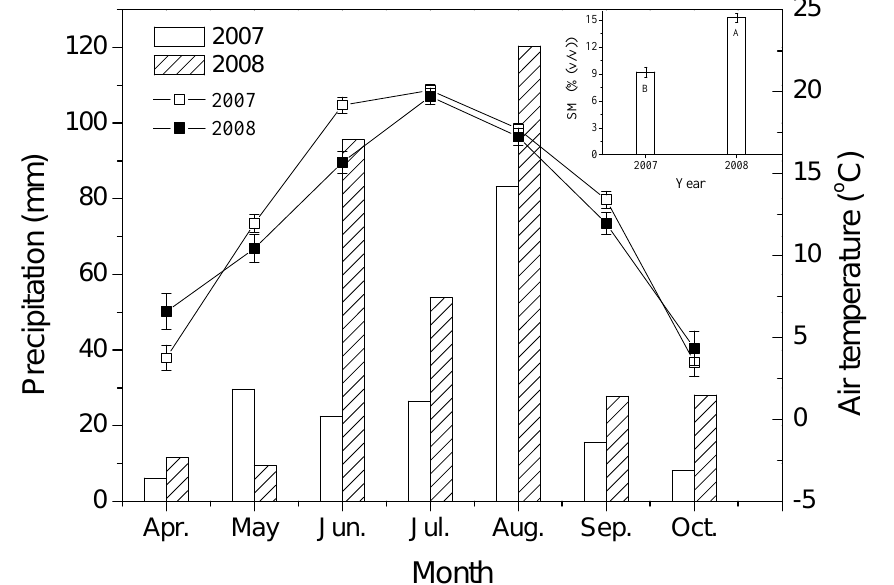
Fig. 1. Temporal variation of monthly precipitation (bar) and air temperature (April–October, line) and daily (1 June–30 September) mean soil moisture (SM, mean ± 1SE, top right corner) in 2007 and 2008. Different letters in the bar indicate significant difference ( p < 0 . 05) in soil moisture. Data are from the eddy tower near to the study site (200m away).